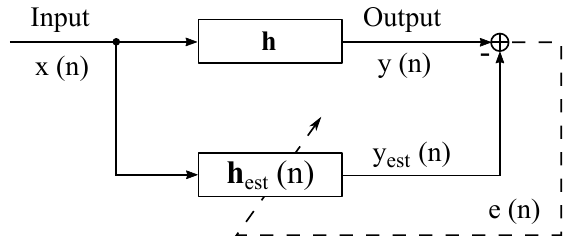
Figure 7. Block diagram for identifying an unknown discrete system with adaptive filtering approaches in the time domain